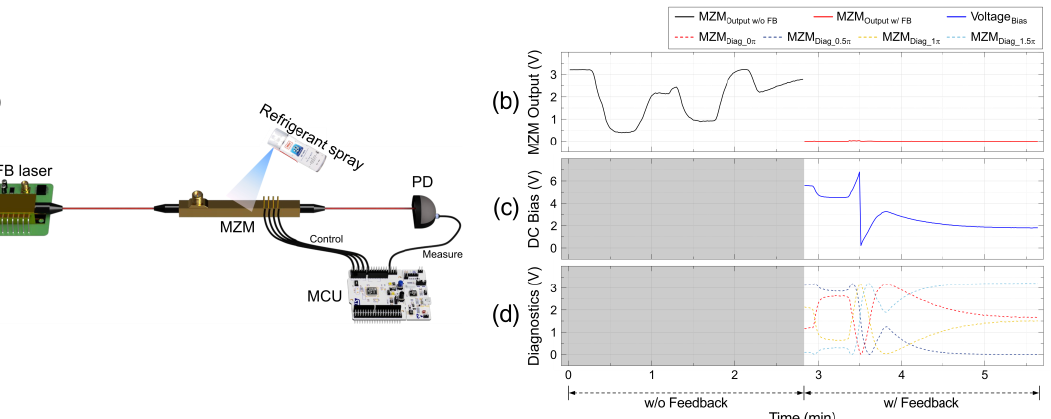
Figure 2. Experimental setup and results of the laboratory tests: ( a ) Experimental setup of the laboratory test; ( b ) MZM output intensity of signal modulation. The black and red solid lines represent the output intensities with and without the proposed control method, respectively; ( c ) Direct-current (DC) bias voltage to compensate for the bias drift; ( d ) MZM output intensities of the diagnostic modulations. The abbreviations are defined as follows: distributed feedback laser (DFB laser); photodiode (PD); and microcontroller unit (MCU).